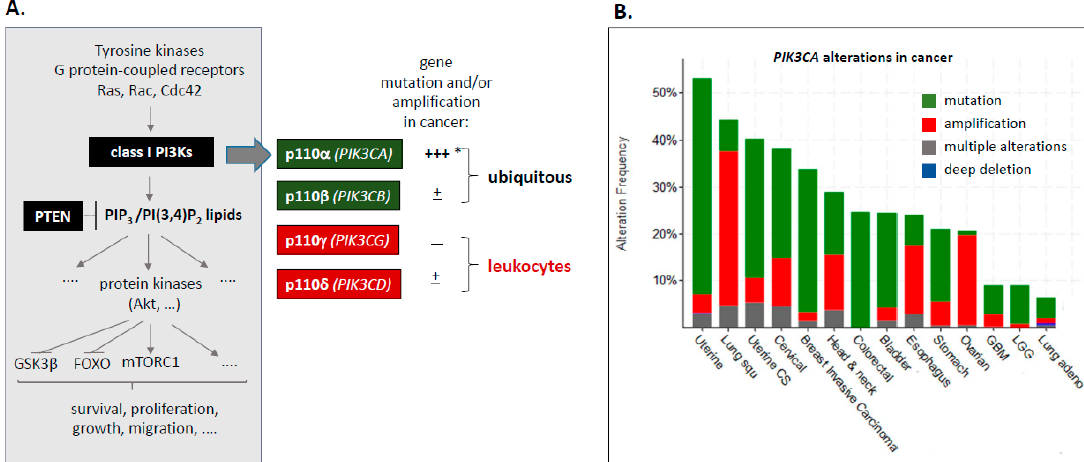
Figure 1. ( A ) Overview of class I PI3K signalling and genetic alterations in PI3K catalytic subunits in cancer. * Note that both wild-type and mutant PIK3CA alleles can be amplified in cancer [4]. A recent analysis showed that PIK3CA -mutant cancers frequently have more than one copy of the mutated PIK3CA gene and / or harbour a second PIK3CA variant [4]. ( B ) Frequency of PIK3CA alterations in a range of human cancers. Data are from cBioportal [5,6] (accessed June 2019). Mammals have four class I PI3K catalytic isoforms (p110 α , β , γ and δ ), encoded by four distinct genes, PIK3CA , PIK3CB , PIK3CG and PIK3CD (Figure 1A). The class IA subset of catalytic PI3Ks (p110 α , β and δ ) occur in a heterodimeric complex with a p85 regulatory subunit, of which there are three separate genes ( PIK3R1 , PIK3R2 and PIK3R3 ). This heterodimerisation keeps the p85/p110